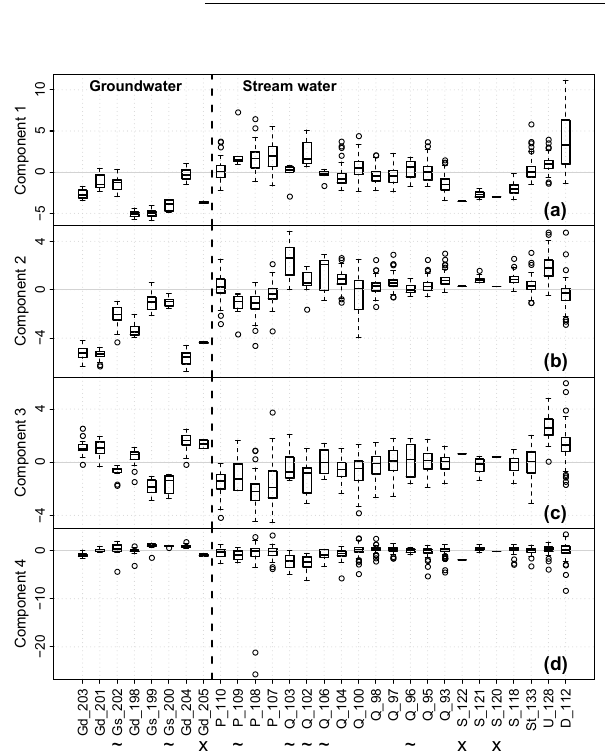
Figure 5. Box plots of scores of component 1 to 4 at different sites. Sites with N < 13 are marked with “ ∼ ”, those with N < 3 with “ X